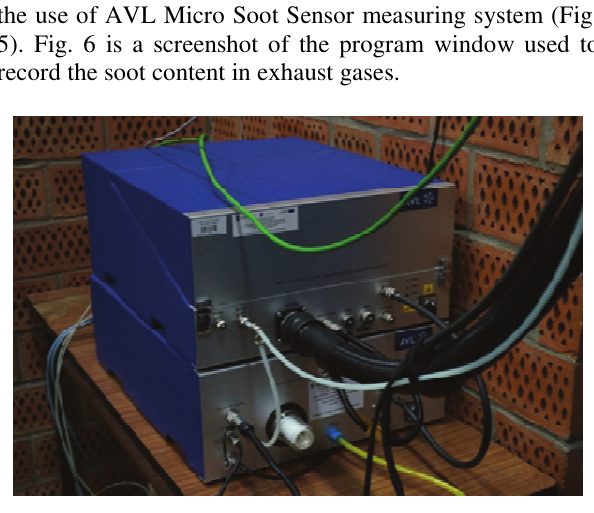
Fig. 5. AVL Micro Soot Sensor system for measuring soot concentrations in the exhaust gases